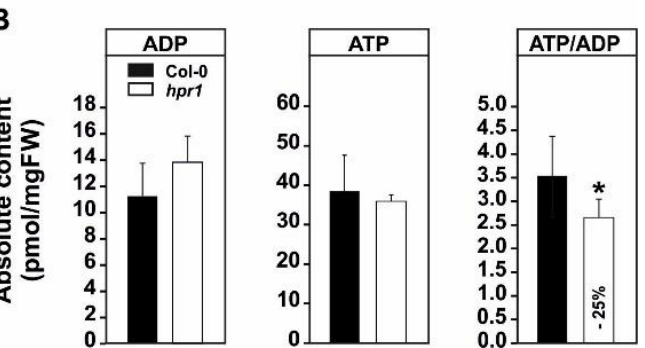
Figure 3. Absolute metabolite contents of selected intermediates related to serine and energy metabolism. Shown are ( A ) absolute amounts of O -acetylserine (OAS), cysteine and glutathione (GSH; sum parameter of GSH + GSSG) and ( B ) energy equivalents (adenosine diphosphate [ADP], adenosine triphosphate [ATP]) form air grown wild-type and hpr1 mutant plants. Shown are means ± SD (five biological replicates) and asterisks show significant changes compared with the wild type according to Student’s t -test (* p < 0.05; ** p < 0.01).